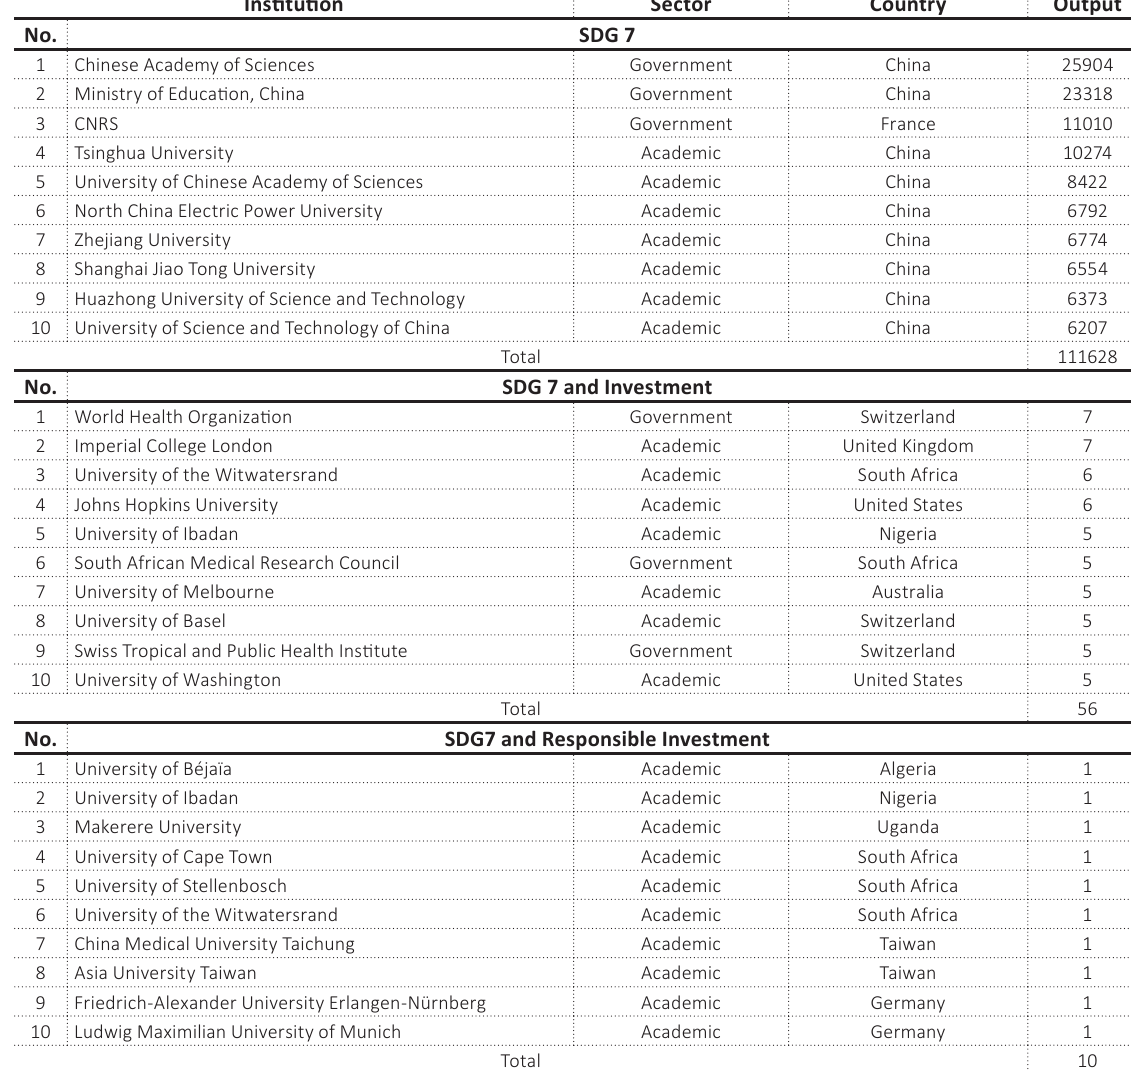
Source: Compiled by authors via SciVal by Elsevier.